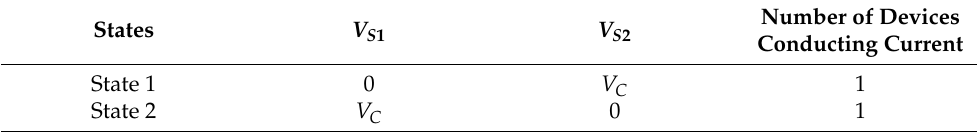
Table 2. HB-SM device blocking voltage.